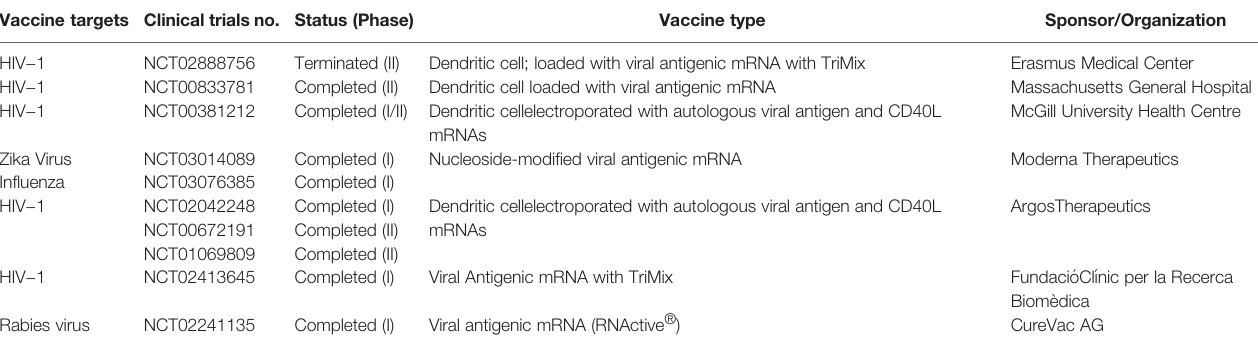
TABLE 3 | Different mRNA vaccines for different diseases which are registered for clinical trial. Vaccine targets Clinical trials no. Status